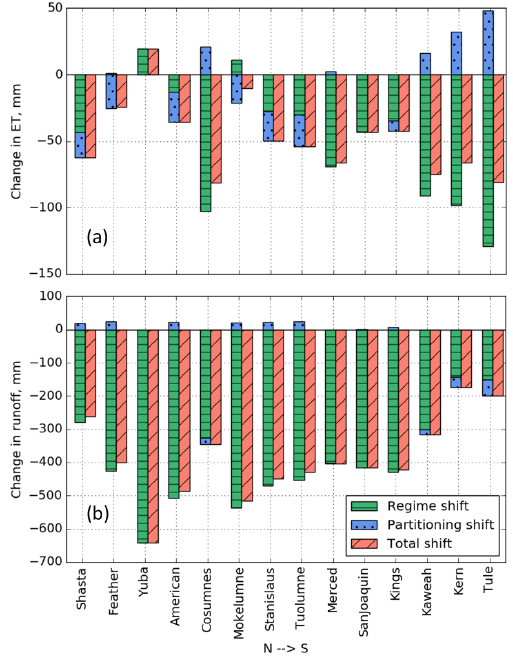
Figure 5. Fraction of changes in ET (a) and runoff (b) during droughts that can be attributed to regime versus partitioning